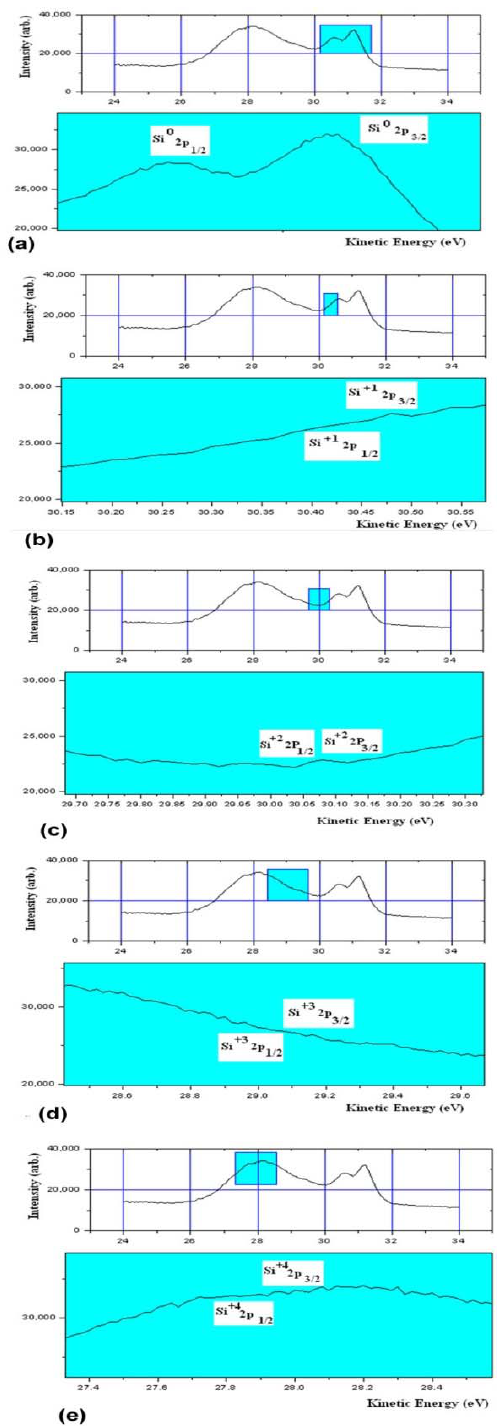
Fig. 1 . Si 2p states of Si(100) spectra after exposure to 300- 2100L total oxygen at 500 0 C: (a) Si 2p 0 , Si 3/2 , (b) Si 2p +1 , Si 2p +1 , (c) Si 2p +2 , Si 2p +2 , 2p 0 1/2 3/2 1/2 3/2 1/2 , Si 2p +3 and (e) Si 2p +4 , Si (d) Si 2p +3 3/2 1/2 3/2